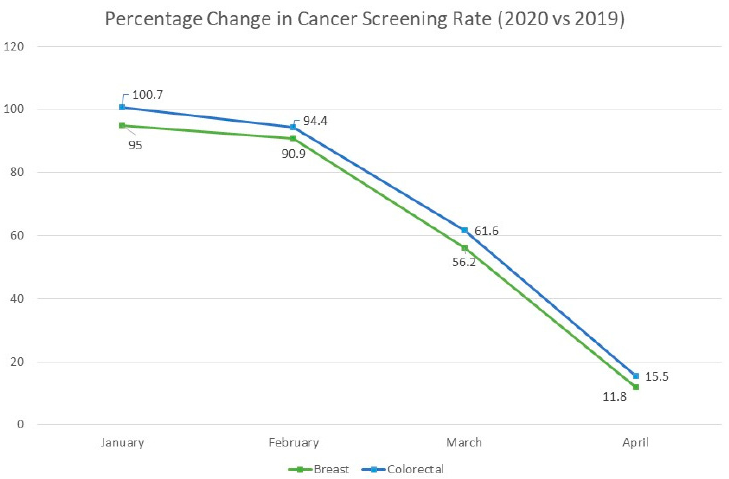
Figure 1. Decline in cancer screening rates during the peak of the COVID-19 pandemic. Data from “Effects of the COVID-19 Pandemic on Cancer-Related Patient Encounters.” JCO Clin. Cancer Informatics (2020).